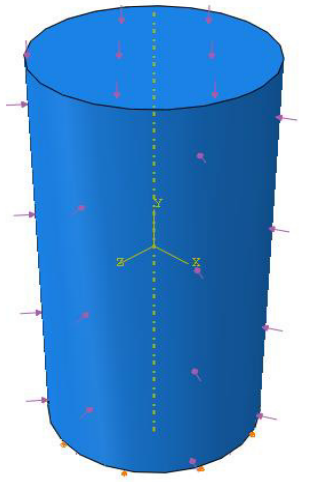
Figure 18. Numerical model of triaxial test.